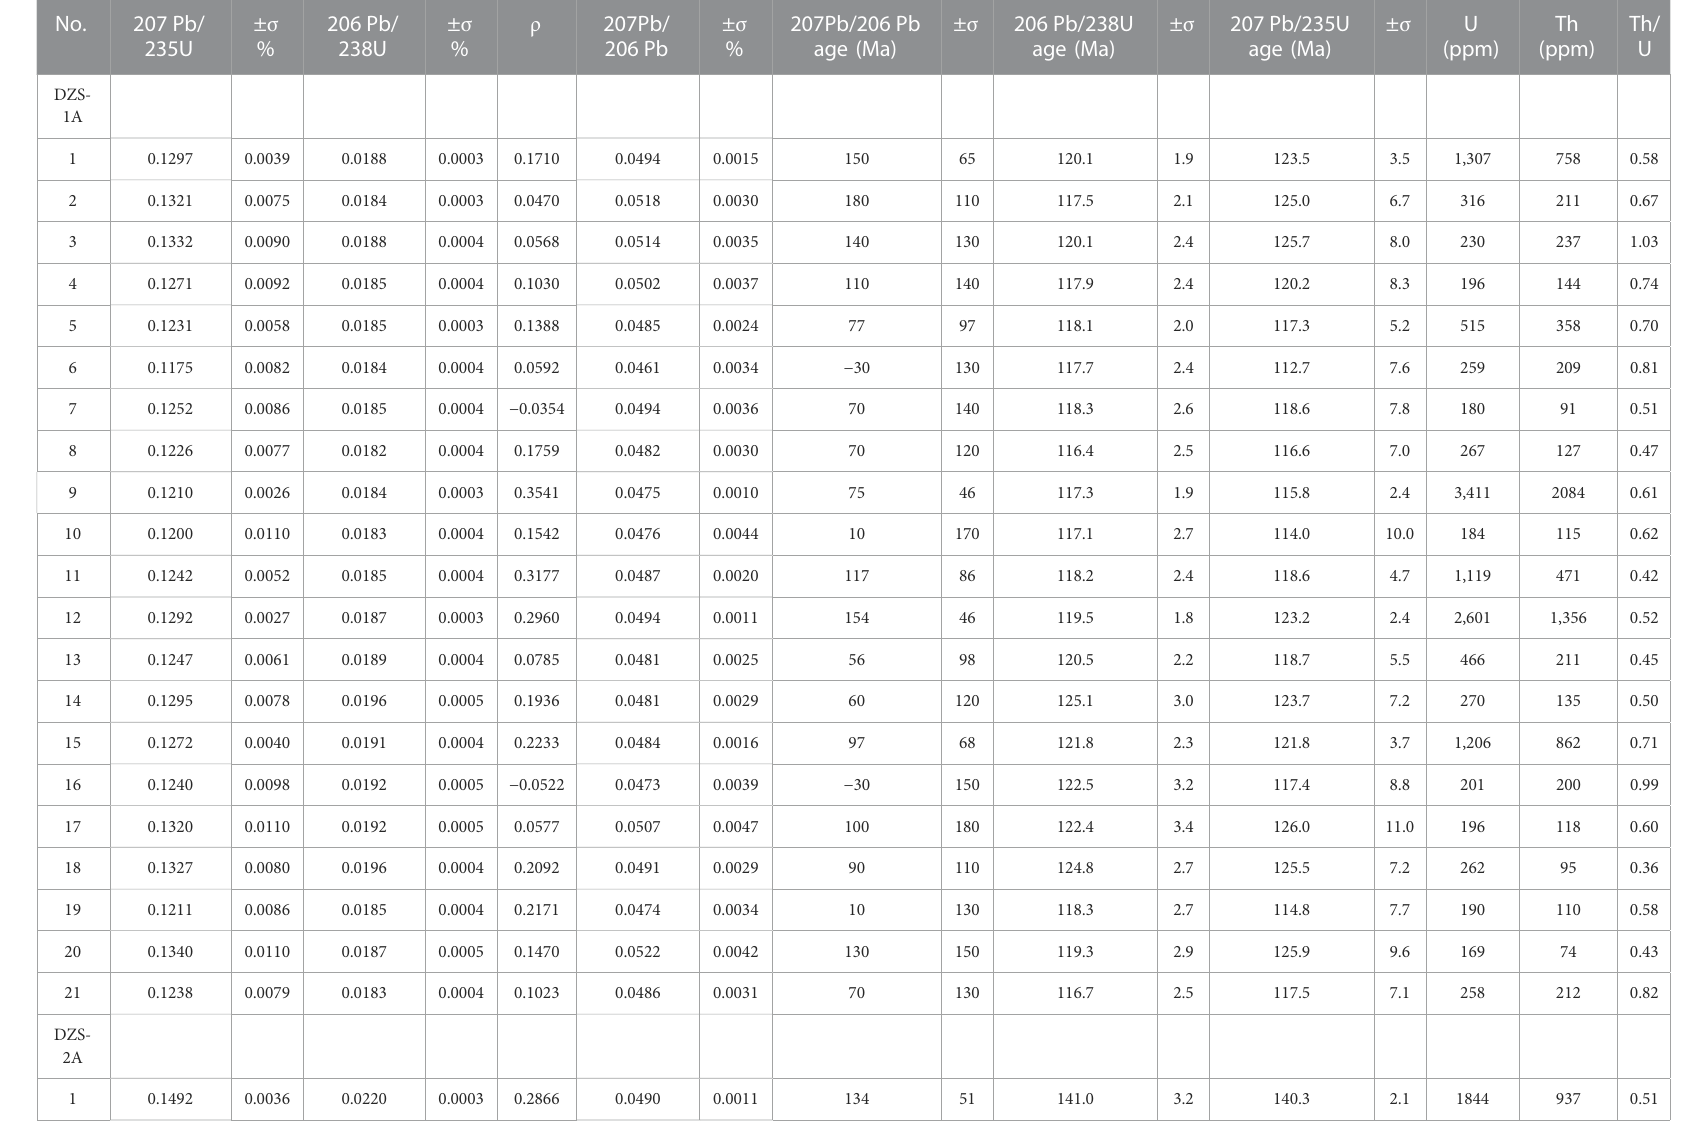
TABLE 2 LA-ICPMS U-Pb age data for zircons from Dazeshan magmatic rocks.